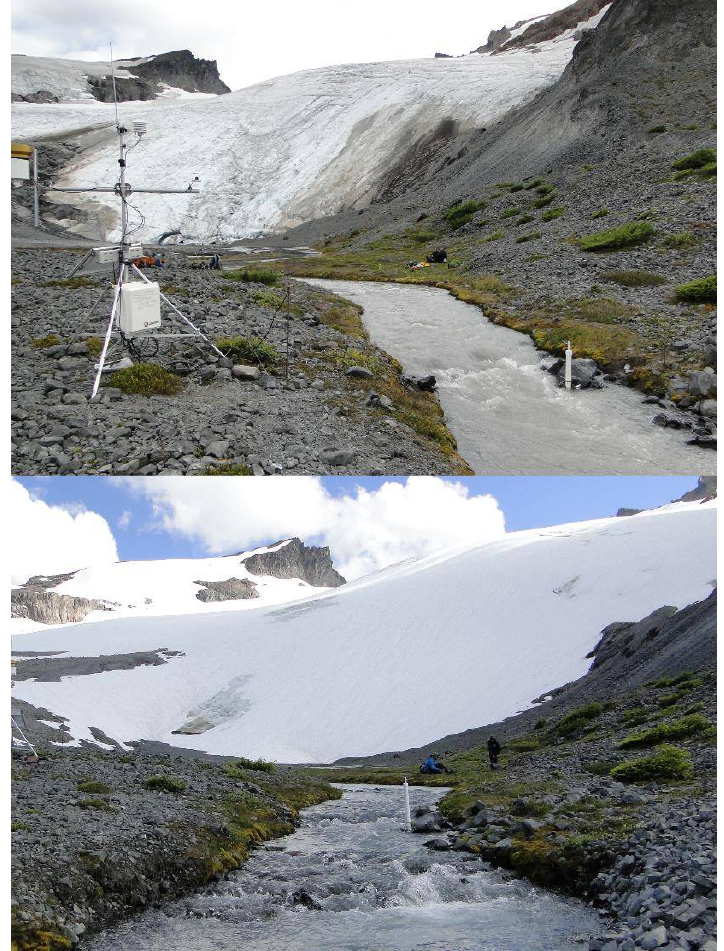
Figure 4. Limited retained snowcover on 8 August 2015 on the Sholes Glacier (above), with the discharge and weather station in foreground. On 8 August 2016, the Sholes Glacier snowcover is typical for early August.